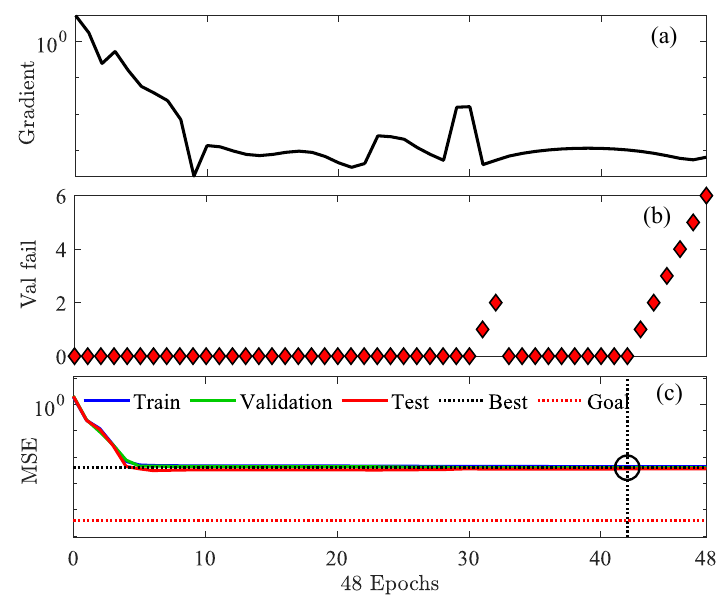
Figure 5. Variations in ( a ) the gradient, ( b ) the number of validation fails, and ( c ) MSE, against epochs.